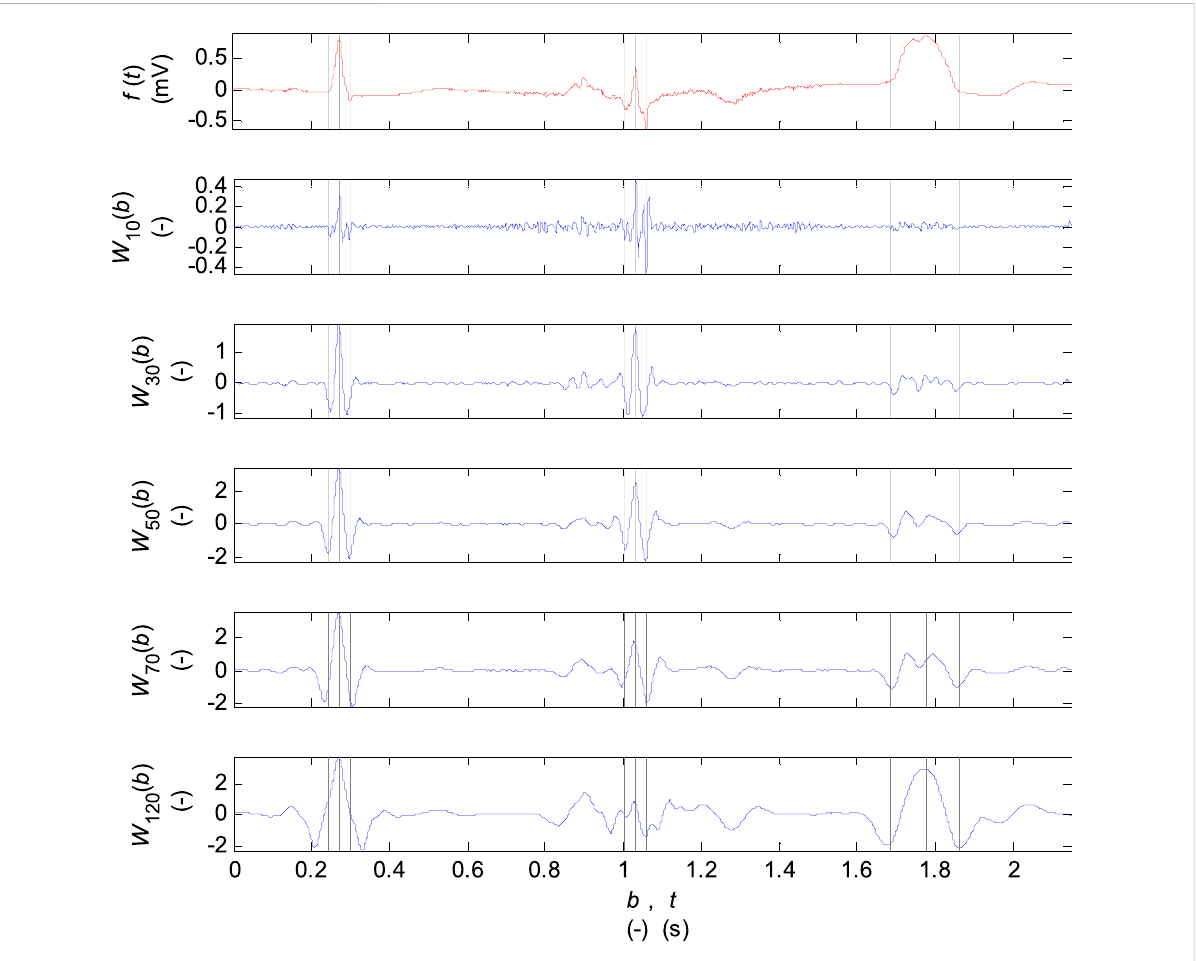
FIGURE 3 Coef fi cients of the wavelet transform for the scale parameter a (cid:2) { 10 , 30 , 50 , 70 , 120 } and the mother biorthogonal 2.2 wavelet. The input signal is one VCG lead of one cardiac cycle of the named records of the diagnostic PTB database: from the left the “ s0130lre ” of a HC patient, the “ s0235lre ” ofaMIpatient, “ thes0448_re ” ofaLBBB patient.The single Q,R,Swavesare markedbydashedlines intheinput